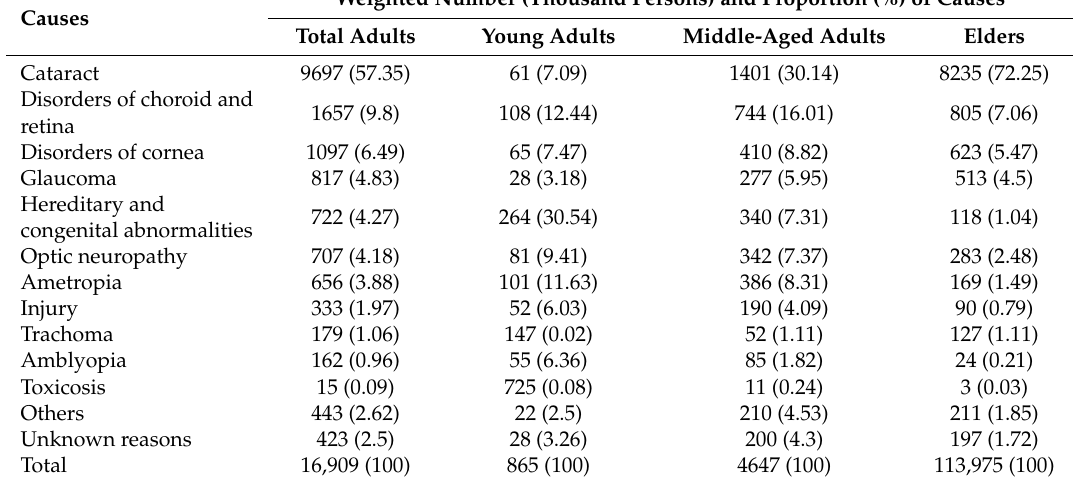
Table 3. Causes of visual impairment among Chinese adults.